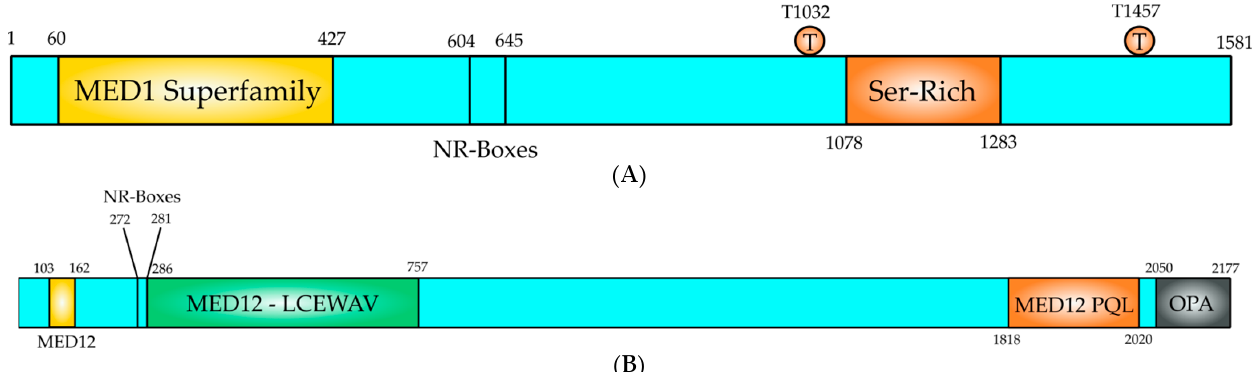
Figure 4. Structural domain organization of MED1 and MED12 proteins. ( A ) MED1 is a 1581 amino acids long polypeptide, which contains functional domains to perform its coactivator function. The MED1 domain (yellow, 60–427) is conserved in MED1 proteins from all eukaryotes. The NR-boxes or LxxLL motifs locate at positions 604 (LTSLL) and 645 (LMNLL) and they serve as protein–protein interaction motifs for nuclear receptors, such as ER. A Ser-Rich domain is located at the C-terminus of the polypeptide (orange, 1078–1283). Two residues (T1032) and (T1457) are phosphorylated by MAPK, an event that increases the activity of MED1, ( B ) The N-terminal region contains the CCNC-CDK8 binding and activation domain (1–50) and contains also a MED1 conserved region (yellow, 103–162). Two overlapping NR-boxes (272–281; LLKLLPLL), which are nuclear receptor binding LxxLL motifs. A MED12-LCEWAV domain (green, 286–757) is present in the polypeptide, which is unknown yet. At the C-terminus contains a Proline-Glutamine-Leucine (orange, 1818–2020; MED12-PQL), which binds effector molecules. At the C-terminal end of the polypeptide is located the odd-paired domain (black, 2250–2177; OPA), which also binds effector molecules.